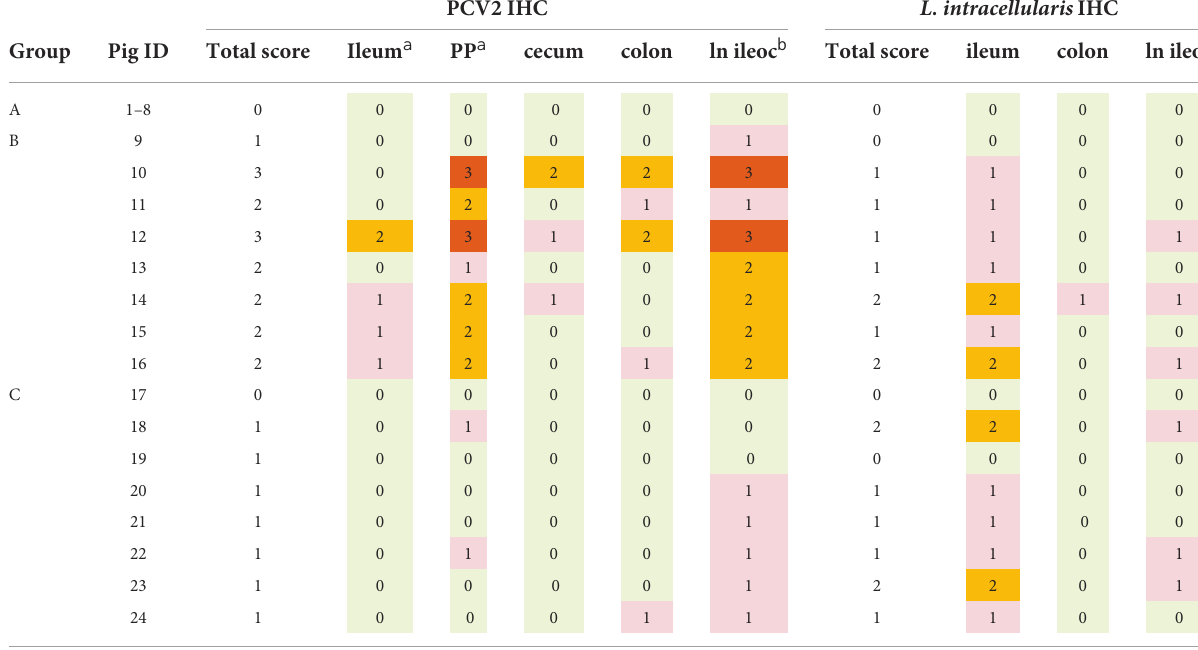
ReactionforbothIHCmethodswasscoredasnostaining(0),focal(1),moderate(2)ormassive(3).Therewasnopositive L.intracellularis IHCreactionincecumorPeyer’spatches. a Ileumisdividedintolymphatictissue,i.e.,Peyer’spatches(“PP”)and“ileum”(ileumwithoutPP)inregardtoPCV2IHCevaluation. b